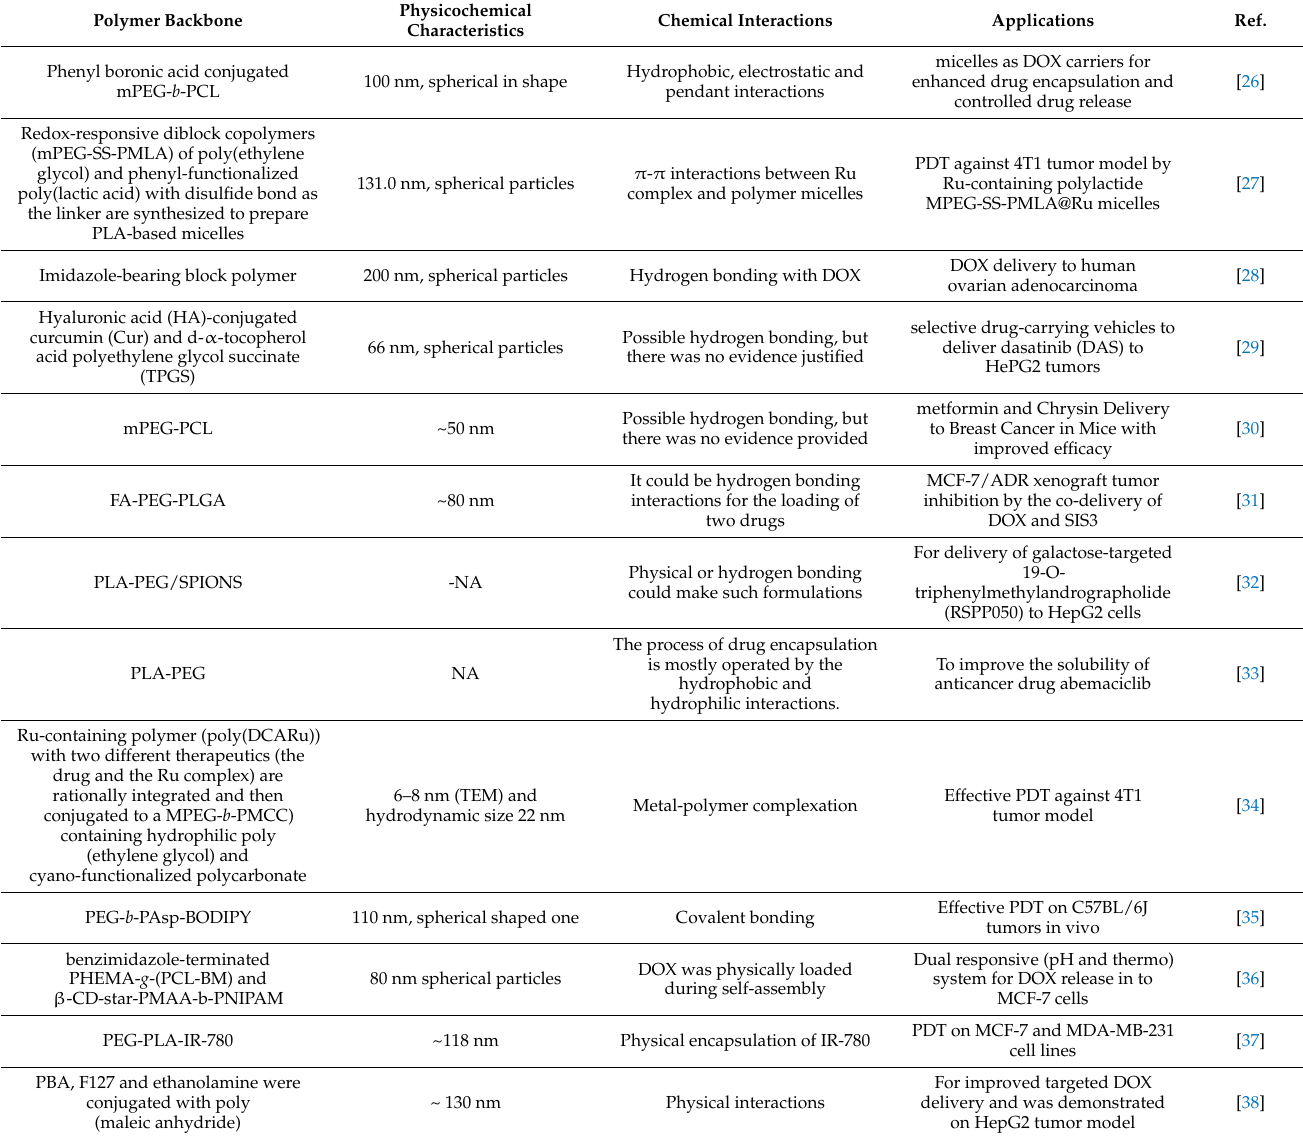
Table 1. Recent polymeric micelles prepared by self-assembly and their physicochemical characteris- tics and